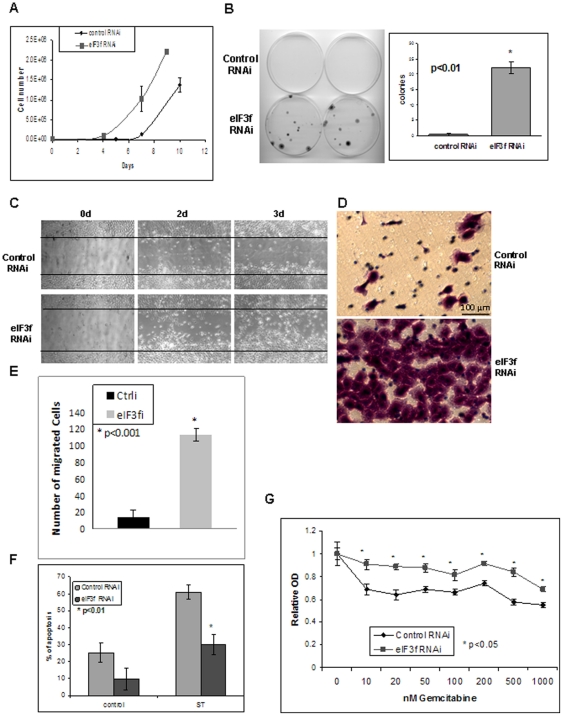
eIF3f-silencing in normal pancreatic epithelial cells led to malignant transformation.(A) In HPDE cells, eIF3f-silenced cells had a higher proliferation rate. Same number of eIF3f stable knockdown (clone #5) and control HPDE cells (5×104 cells/plate) were seeded in triplicate on 100-mm plates and total cell numbers were counted every 2–3 days. (B) eIF3f-silenced cells formed more colonies. Same number (1000 cells) of eIF3f stable knockdown and control HPDE cells were seeded on 100 mm plates and colony formation was measured after 14 days. (C–E) eIF3f-silenced cells migrated faster than control cells. Confluent eIF3f RNAi or control RNAi HPDE cells were used for a scratch assay and pictures were taken at the indicated time as described in Materials and Methods (C). Same cells were also used for a migration assay using a Transwell culture system as described in Materials and Methods. A representative picture of the migrated cells stained with crystal violet on the filter was shown (D). Average number of migrated cells were counted and statistic difference between 2 cell lines was shown (E). (F) eIF3f-silenced cells were more resistant to apoptosis. eIF3f or control RNAi HPDE cells were treated with staurosporine (10 ng/ml) (ST) to trigger apoptosis. Apoptosis was measured after 24 h for ST using Annexin V staining and flow cytometry. Percentage of apoptotic cells out of total cells from 3 independent experiments was shown. (G) eIF3f-silenced cells were more resistant to gemcitabine treatment. eIF3f or control RNAi HPDE cells were treated with different concentrations of gemcitabine for 24 h before measuring the cell survival by MTT assay. The average ratio of gemcitabine/vehicle-treated cells OD from 3 independent experiments was plotted against gemcitabine concentrations.